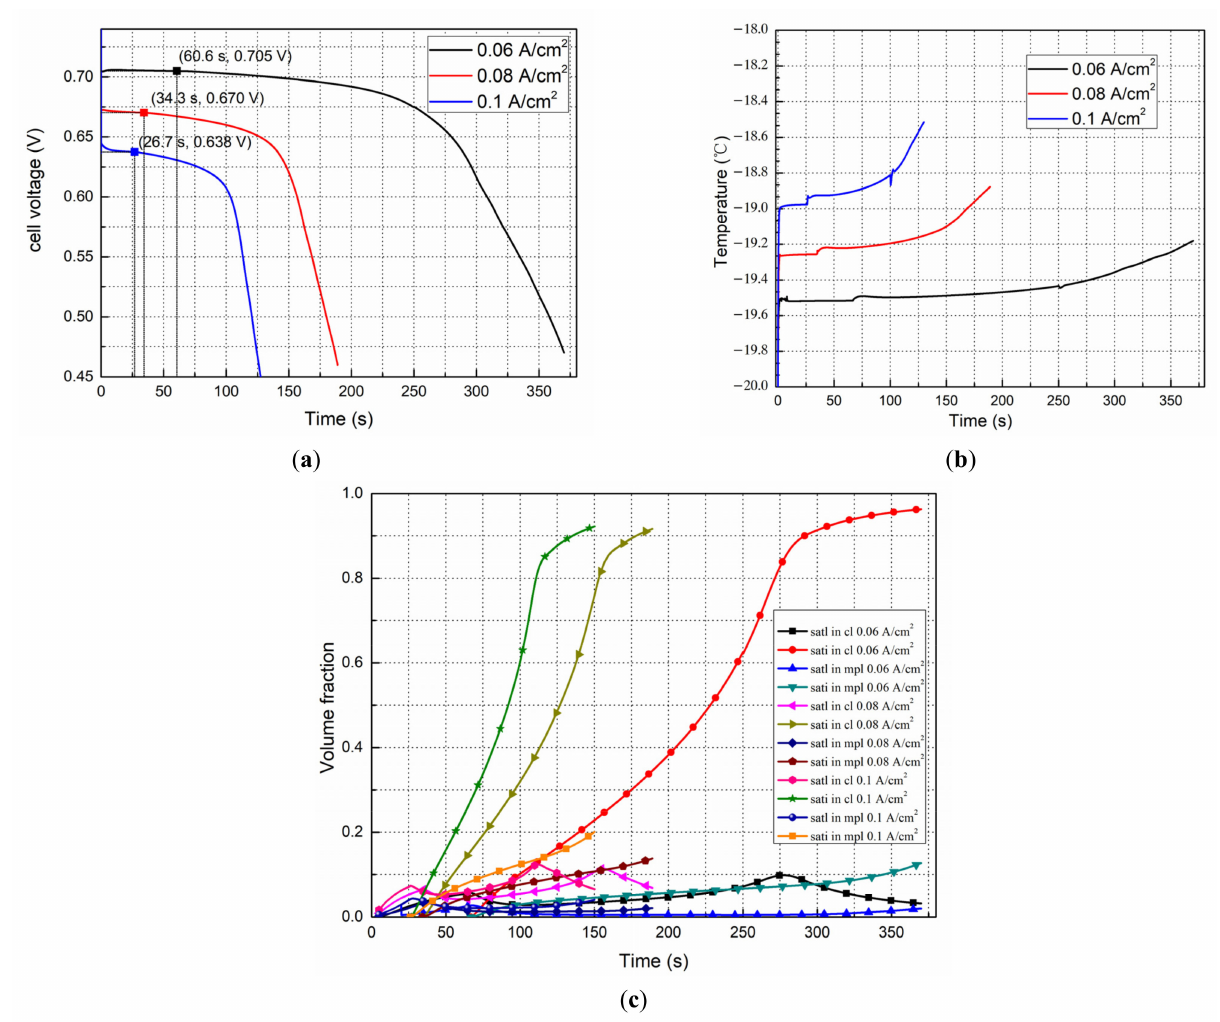
Figure 9. Effects of the current density on the start processes from − 20 ◦ C with initial λ = 6. ( a ) Performance evolution, ( b ) Temperature evolution, ( c ) Liquid and ice saturation in the cathode CL and